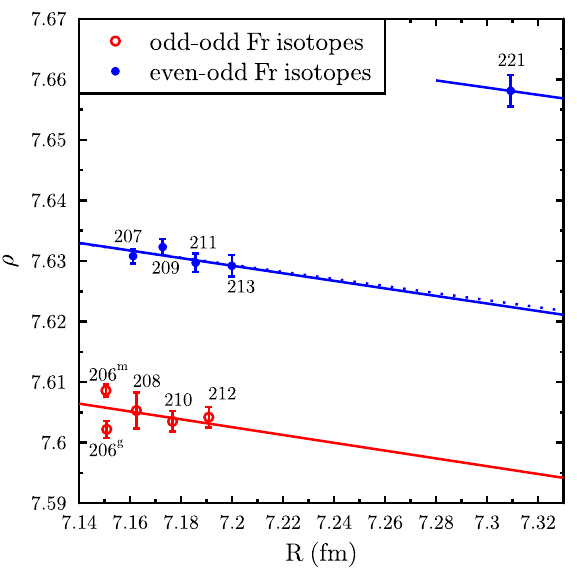
Figure 2. Experimentally measured ratios ρ = A ( 7 s ) / A ( 7 p 1/2 ) for even–odd and odd–odd isotopes of francium [13]. The nuclear radii R are taken from Reference [30]. Solid lines are the one-parameter fits by Equation (10); dashed line corresponds to the two-parameter fit. For even–odd isotopes, we use d nuc = 0.3 [21] and parameters ρ 0 (one-parameter fit), or ρ 0 and ( b N + d nuc b M ) (two-parameter